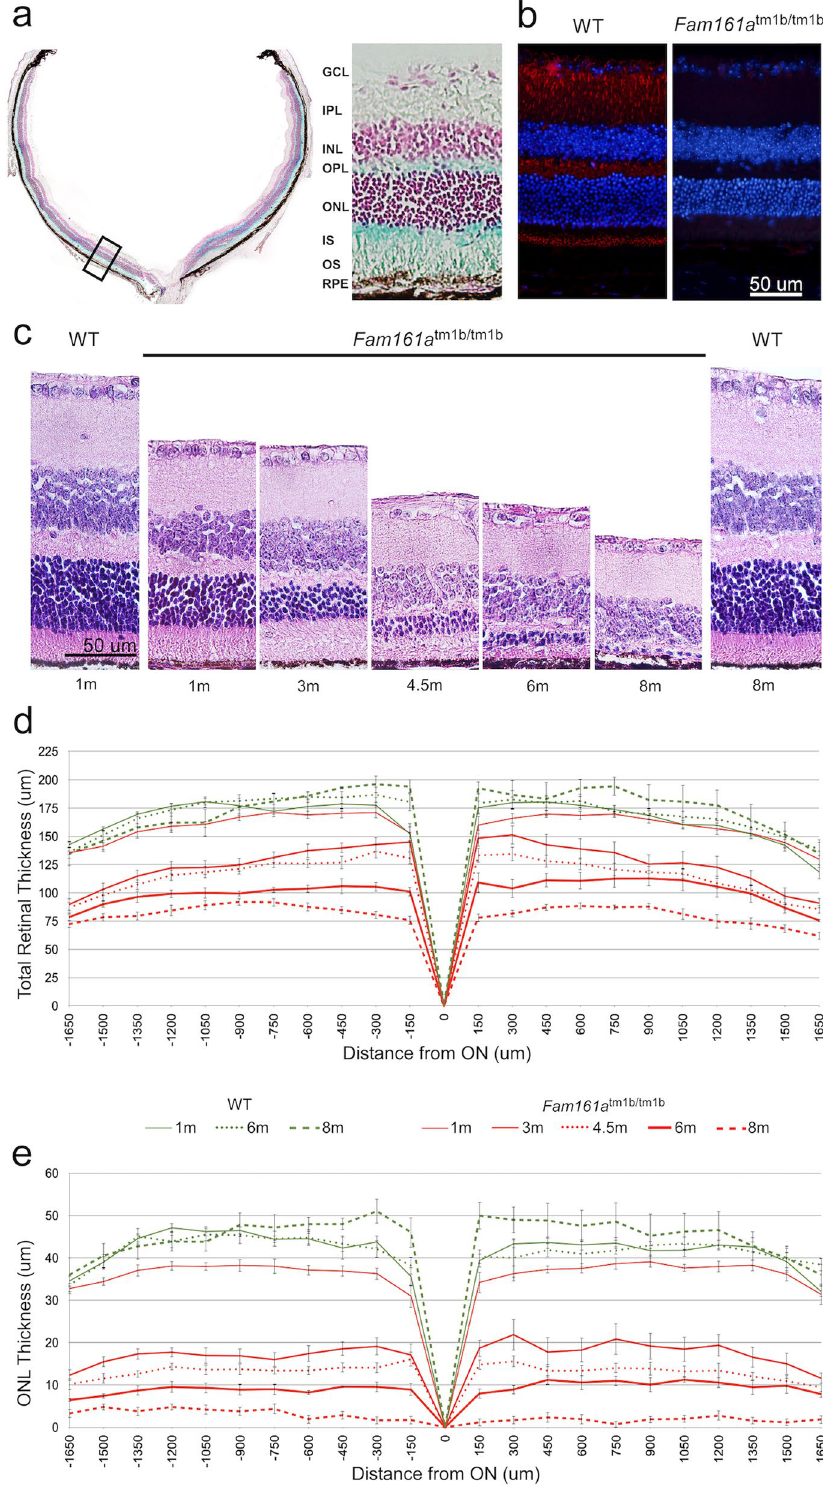
Figure 2. Retinal structure in Fam161a tm1b/tm1b and WT mice. ( a ) LacZ expression in Fam161a tm1b/tm1b mouse retina. LacZ cassette was inserted instead of exon 3 of Fam161a , and therefore the cells that express LacZ are the cells that originally expressed Fam161a . Blue color represents the area where LacZ was able to dismantle β-gal. Nuclei of different cells are stained in red. A black square (left) represents the region chosen for magnification (right side). ( b ) Representative IHC images from 1 month old WT and Fam161a tm1b/tm1b mouse retinas stained with anti-Fam161a antibody. The retina was counterstained with DAPI to define nuclear layers. Original magnification: × 20. Scale bar: 50 μm. ( c ) Retinal histology in Fam161a tm1b/tm1b and WT mice. Representative images of mid- peripheral retina stained with hematoxylin and eosin. Original magnification: × 40. Scale bar: 50 μm. ( d ) Total retinal thickness in Fam161a tm1b/tm1b and WT mice. ( e ) ONL thickness in Fam161a tm1b/tm1b and WT mice. The measurements in d and e panels were done in fragments of 150 µm from the optic nerve (ON) towards the nasal (N) and temporal (T)